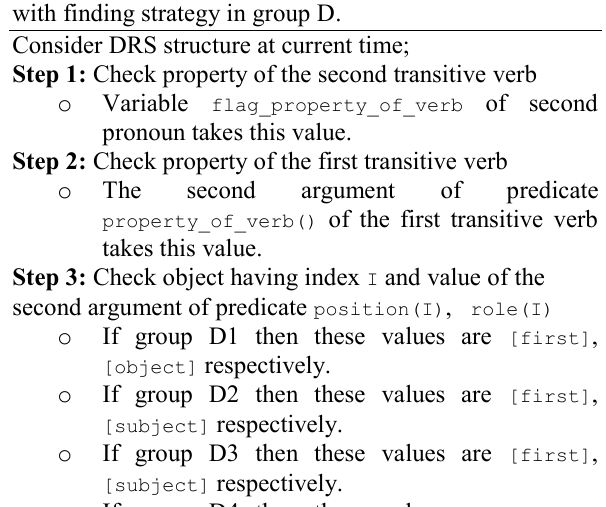
Algorithm 6 : Determine the antecedents for pronouns with finding strategy in group D.